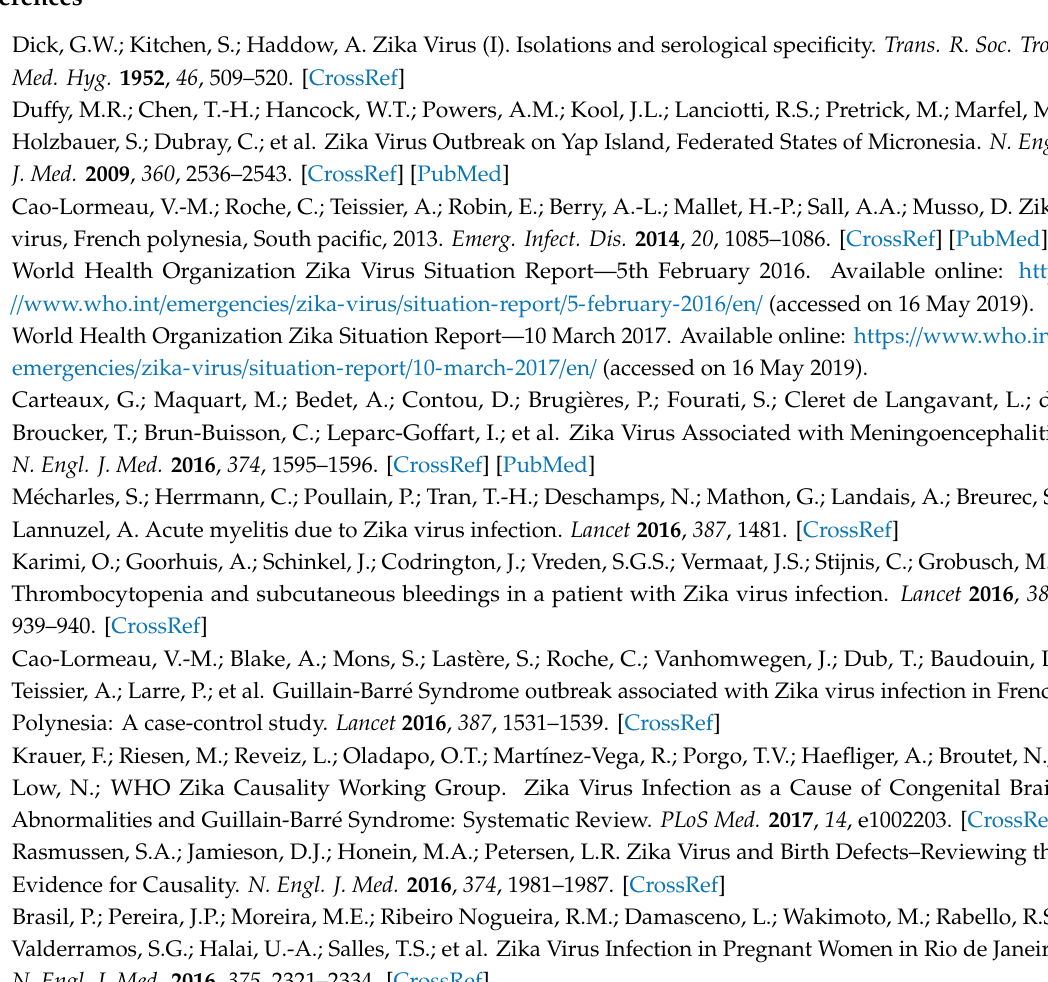
Figure S1: The e ff ect of freeze-stored breast milk on ZIKV infection. Figure S2: Cytotoxicity of the fresh and incubated breast milk samples. Figure S3: Kinetics of ZIKV inhibition by incubated individual breast milk samples at di ff erent temperatures. Figure S4: Bar diagram of dose-dependent ZIKV inhibition by incubated breast milk sample of donor 1. Figure S5: Bar diagram of dose-dependent ZIKV inhibition by incubated breast milk sample of donor 2. Figure S6: Bar diagram of dose-dependent ZIKV inhibition by incubated breast milk sample of donor